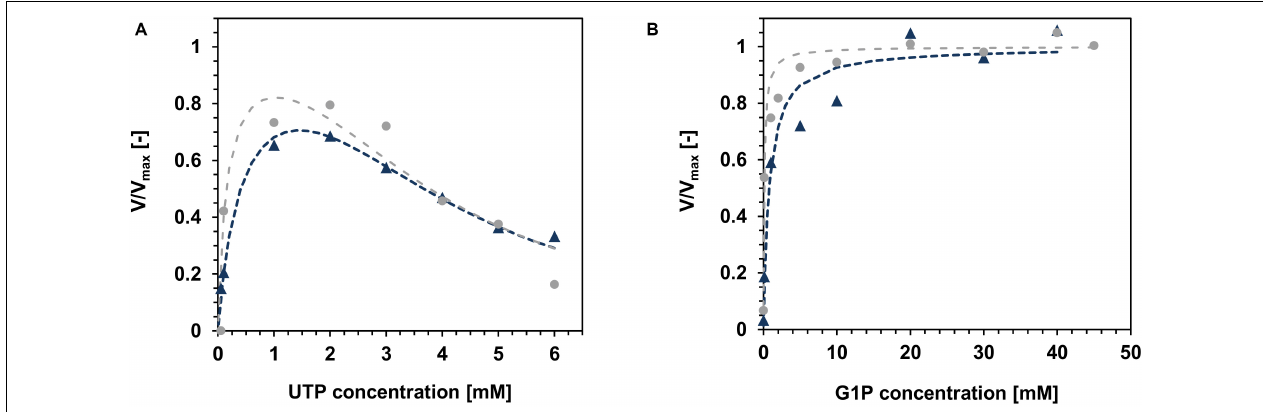
FIGURE 8 | Variation of the substrate concentrations for kinetic modeling. (A) : UTP. Reaction mixtures contained 0.05–6 mM UTP, 30 mM G1P, 3 mM MgCl 2 , 50 mM Hepes, pH 7.0, 0.013 µ g mL − 1 free Ta GalU and 0.1036 µ g mL − 1 Ta GalU on MCF, respectively, reaction temperature was set to 50 ◦ C in 1 mL (free Ta GalU) and 3 mL ( Ta GalU on MCF) reaction volume. Data were fitted to the model of Yano and Koga (Yano and Koga, 1969) for substrate inhibition [see section “HPLC Measurement and Determination of the Specific Ta GalU Enzyme Activity,” equation (2)] and (B) : G1P. Reaction mixture contained 2 mM UTP, 0.01-40 mM G1P ( Ta GalU on MCF) or 0.01–45 mM G1P (free Ta GalU), 3 mM MgCl 2 , 50 mM Hepes, pH 7.0, 0.013 µ g mL − 1 free Ta GalU and 0.3109 µ g mL 1 Ta GalU on MCF, respectively, reaction temperature was set to 50 ◦ C in 1 mL (free Ta GalU) and 3 mL ( Ta GalU on MCF) reaction volume. Data were fitted to the Michaelis-Menten Equation [section “HPLC Measurement and Determination of the Specific Ta GalU Enzyme Activity,” equation (1)]. Gray circles and gray dashed lines show the data points and fits for the free Ta GalU, blue triangles and blue dotted lines show the data points and fits for the immobilized Ta GalU on MCF.